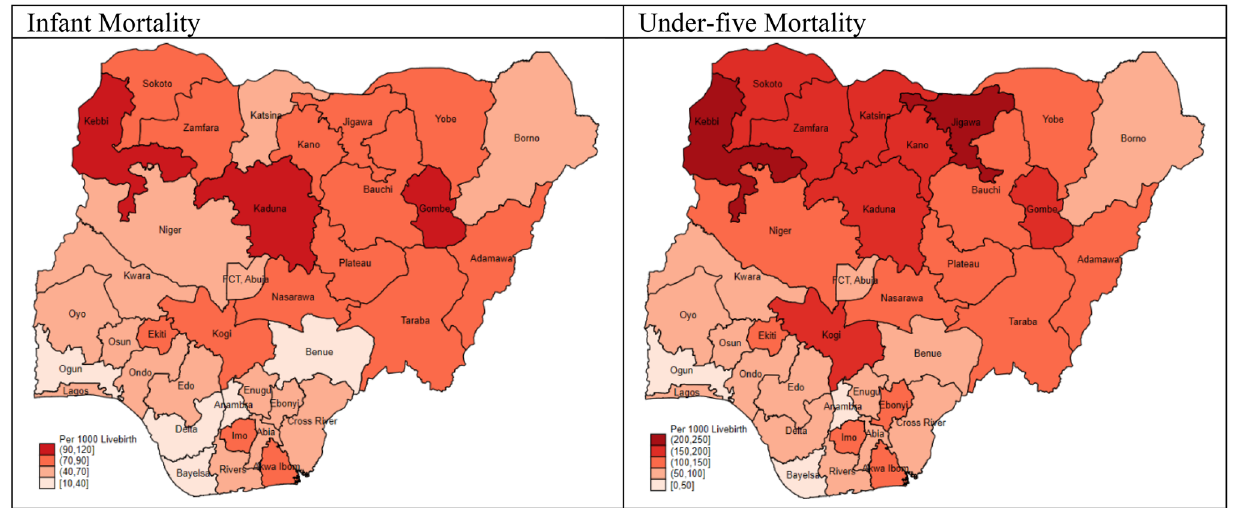
Figure 2. Distribution of infant and under-five mortality per 1000 live births by the States in Nigeria (NDHS